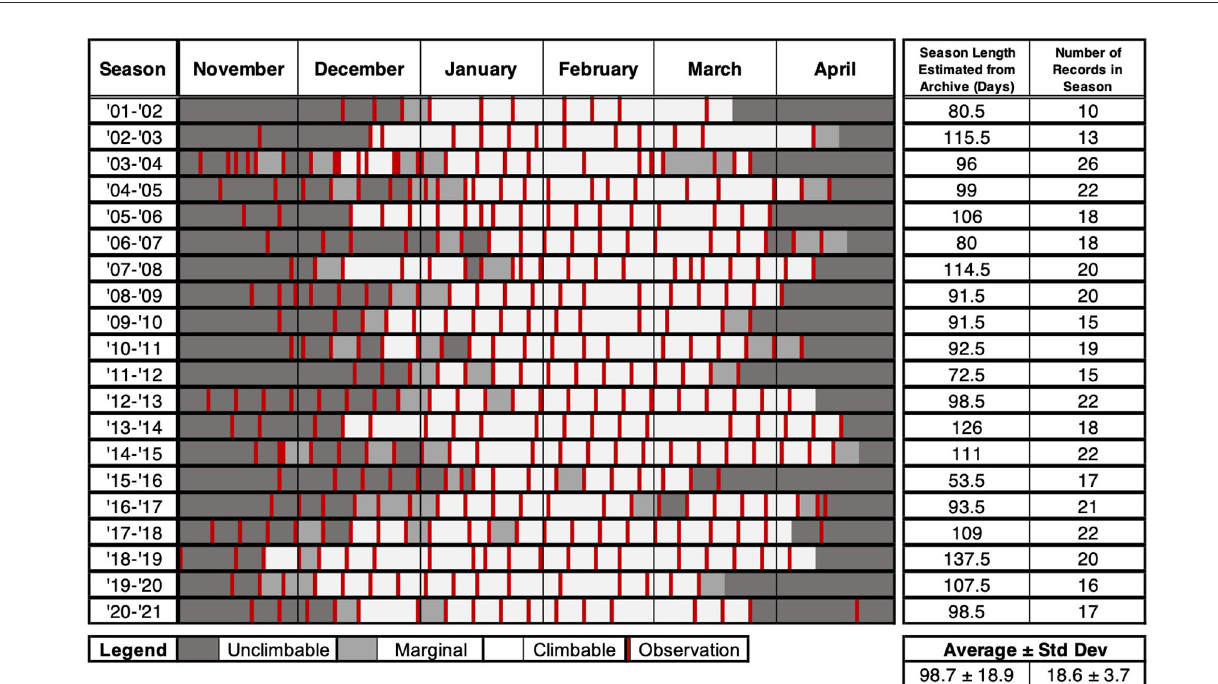
Valley (University of New Hampshire IRB-FY2021-40).